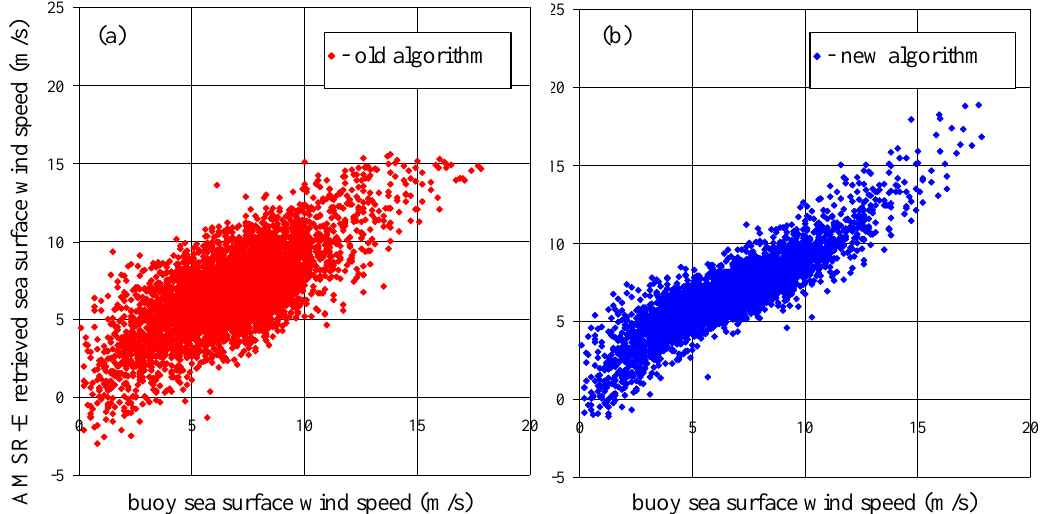
Figure 5. Scatter plots of AMSR-E retrieved WS versus buoy measured WS: ( a ) the algorithm is trained using brightness temperature calculations with an old geophysical model [21], ( b ) the new